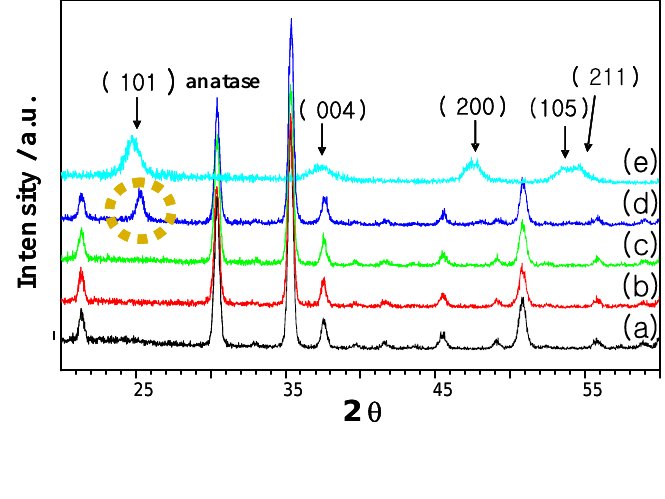
Figure 2. XRD data: (a) ITO, (b) Sintered at 200 °C, (c) 350 °C, (d) 500 °C, (e) TiO